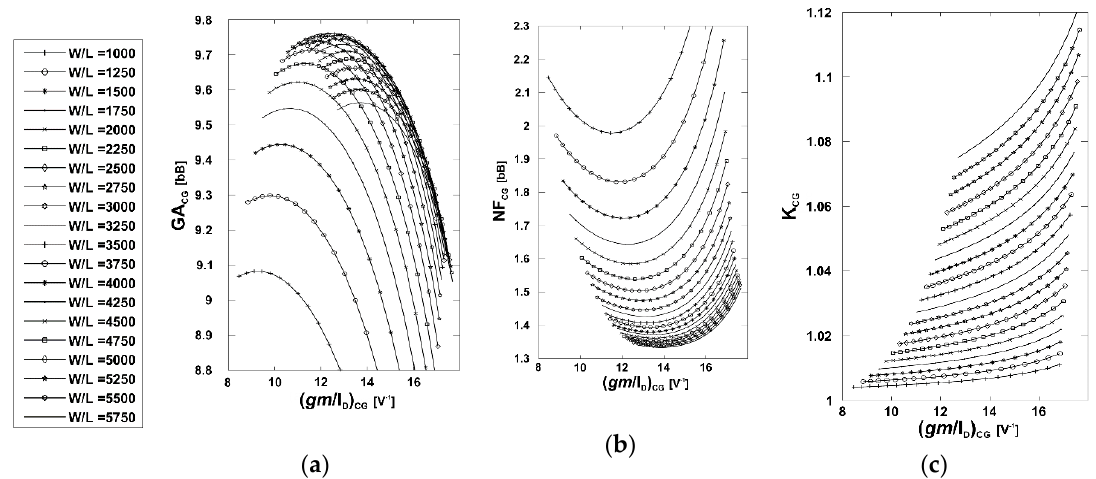
Figure 12. CG stage response as a function of the gm / I D : ( a ) gain; ( b ) noise figure; ( c ) stability factor K.